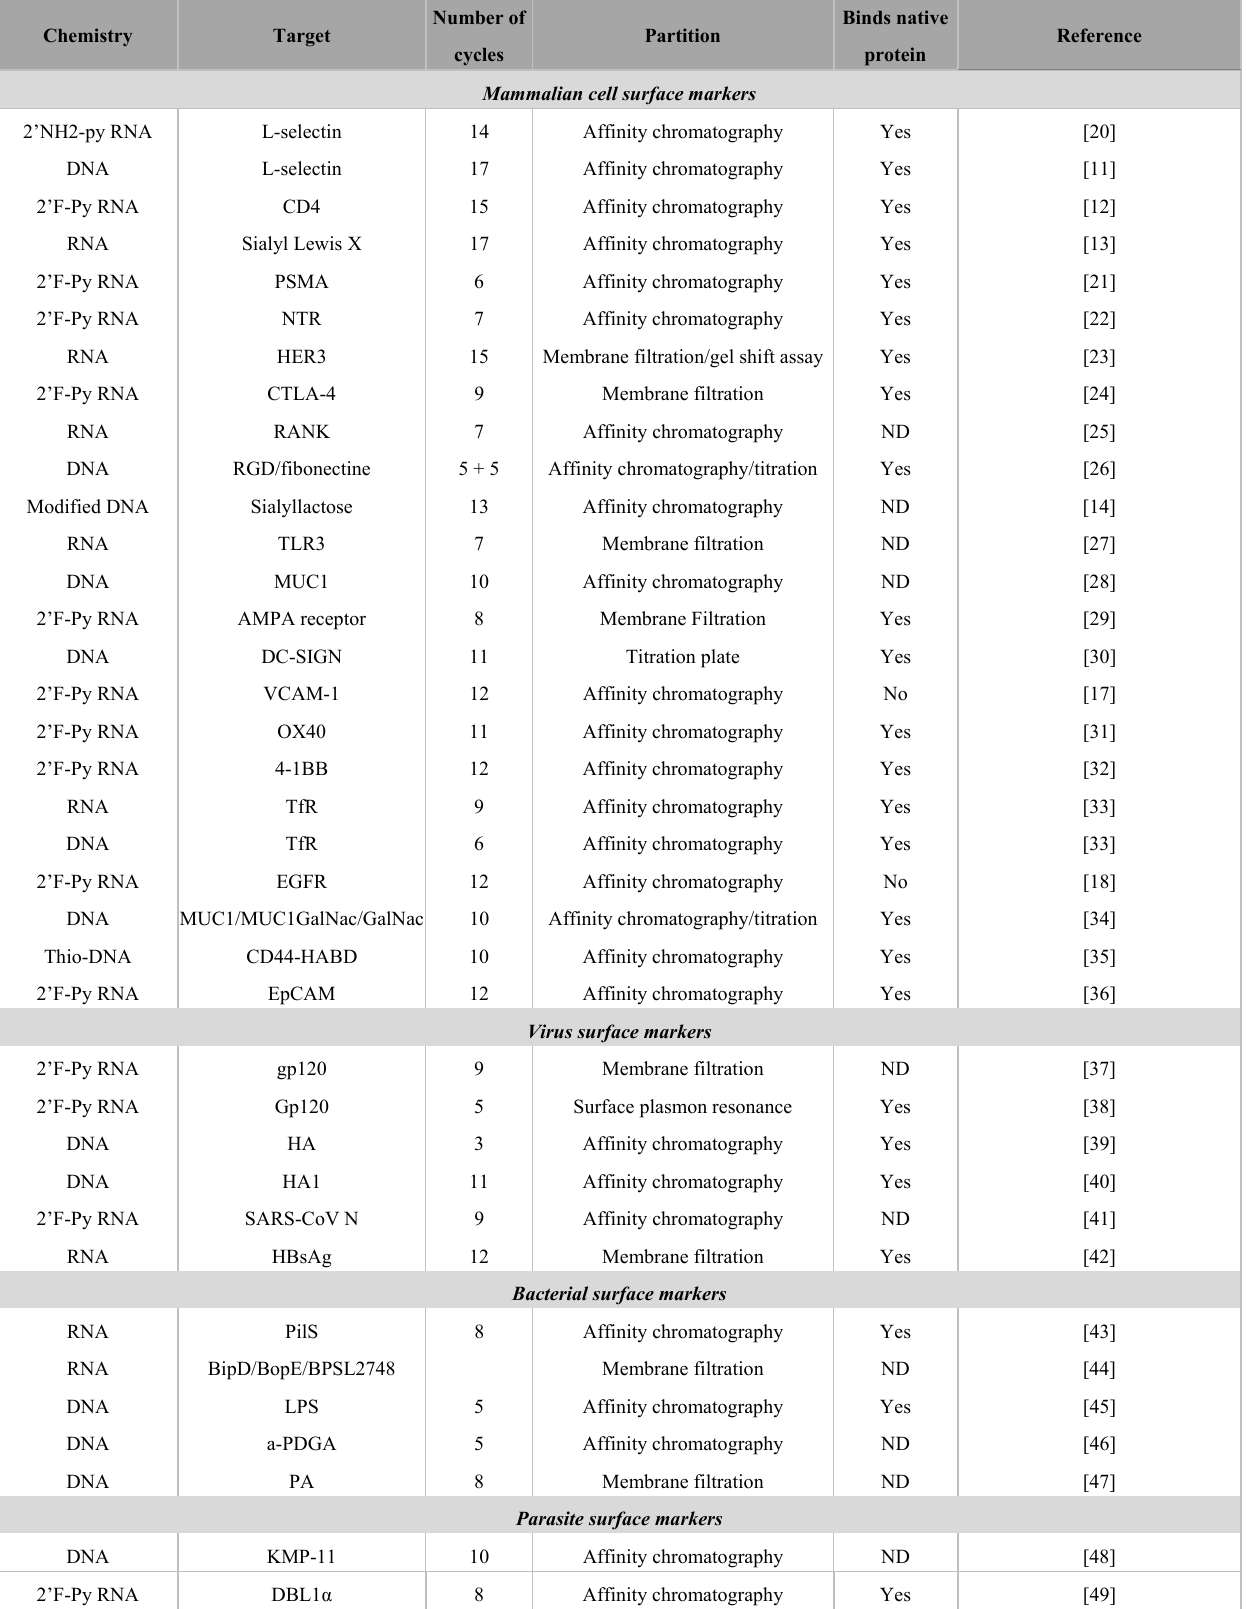
Table 1. SELEX directed against purified cell surface biomarkers.